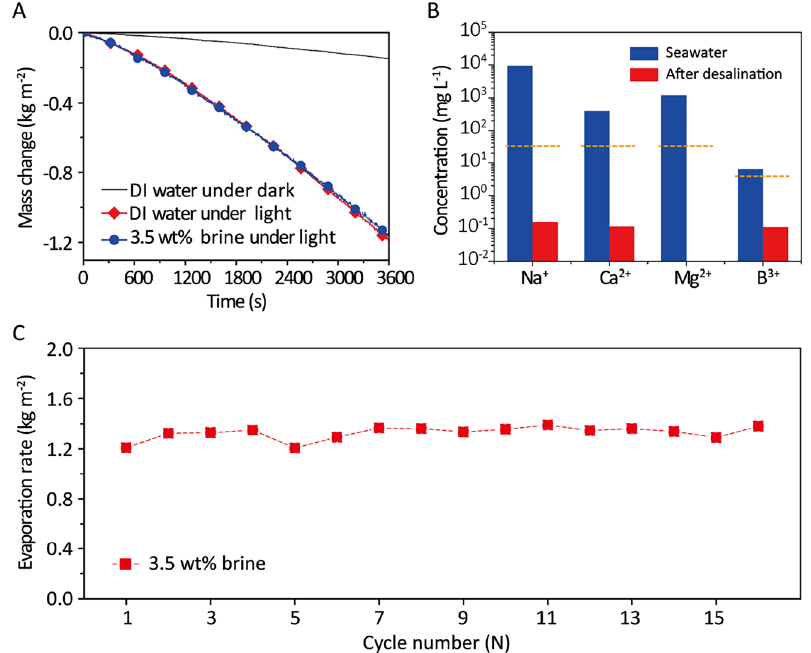
fl oating GO fi lm/rGO membrane is dried and weighed for quantifying the salt-rejecting ability. Figure 4A demon- strates the measured m n − m of the GO fi lm and the rGO 1 membrane (dry state) after each cycle of solar desalina- tion with brine sources of different salinities (3.5, 5, and 8 wt%). It is found that the weight of the dried GO fi lm